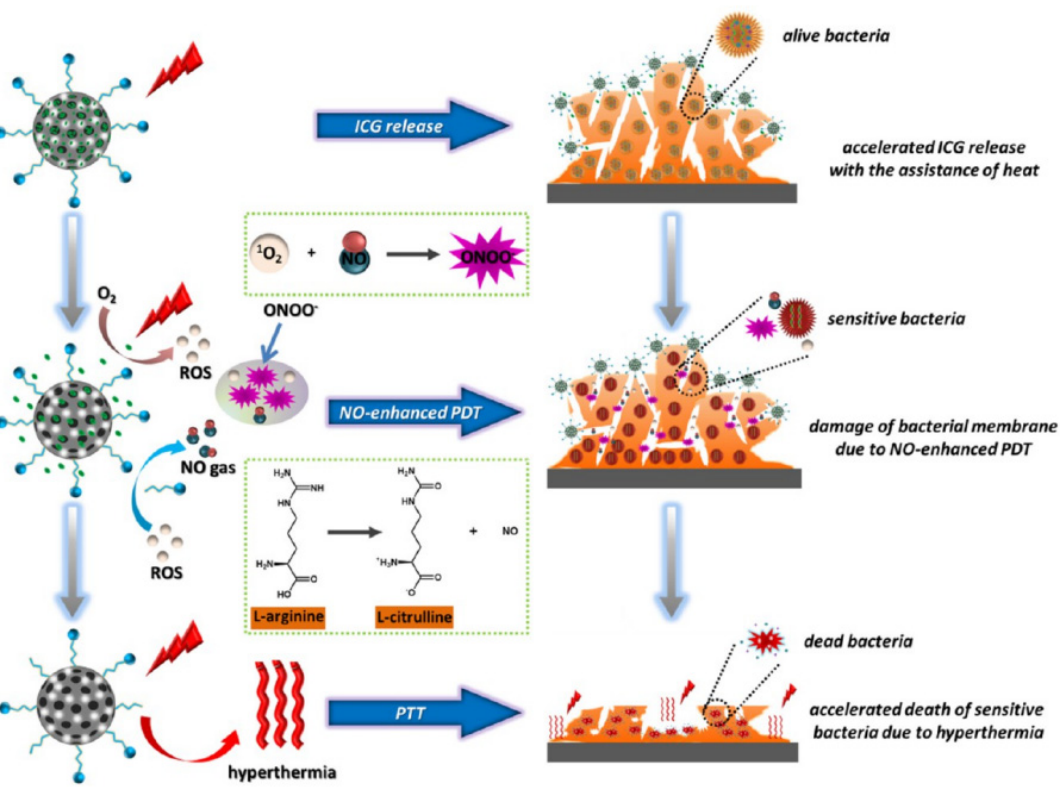
Figure 4. Mechanism of action of PDT-, PTT-, and NO-mediated killing of bacteria and eradication of biofilm by AI-MDPA. NIR irradiation generates heat, ROS, and NO that sensitizes bacterial cells to hyperthermia. Reproduced with permission from [135].